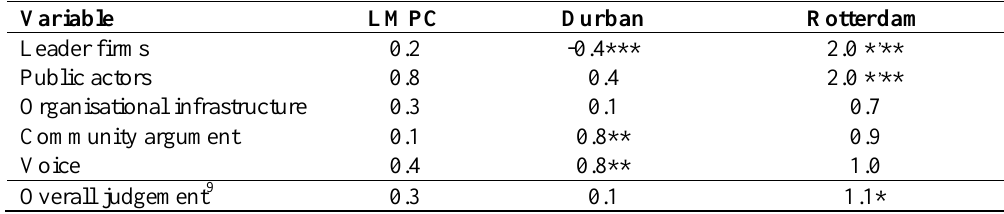
Table 6. Expert evaluation of the quality of the